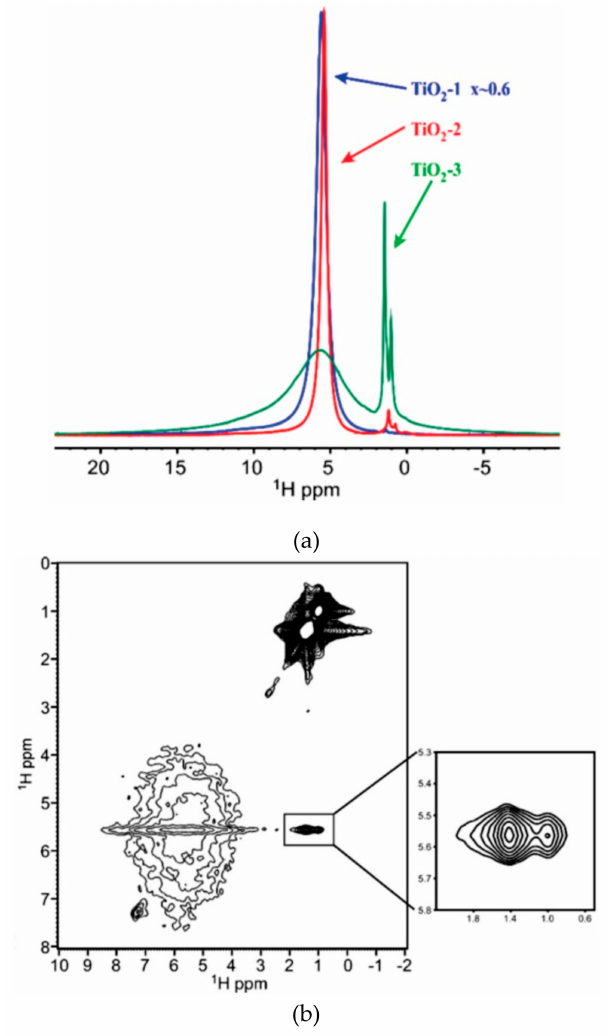
Figure 8. ( a ) 1 H MAS ssNMR spectra of TiO 2 -1 (blue), TiO 2 -2 (red), and TiO 2 -3 (green) materials; ( b ) 2D 1 H- 1 H correlation spectrum of TiO 2 -3 sample. Main TiO 2 -2 signals are at 0.8, 1.2, and 5.4 ppm. Main TiO 2 -3 signals are at 1.0, 1.5, and 5.7 ppm, with a clear, but small contribution also at 1.3